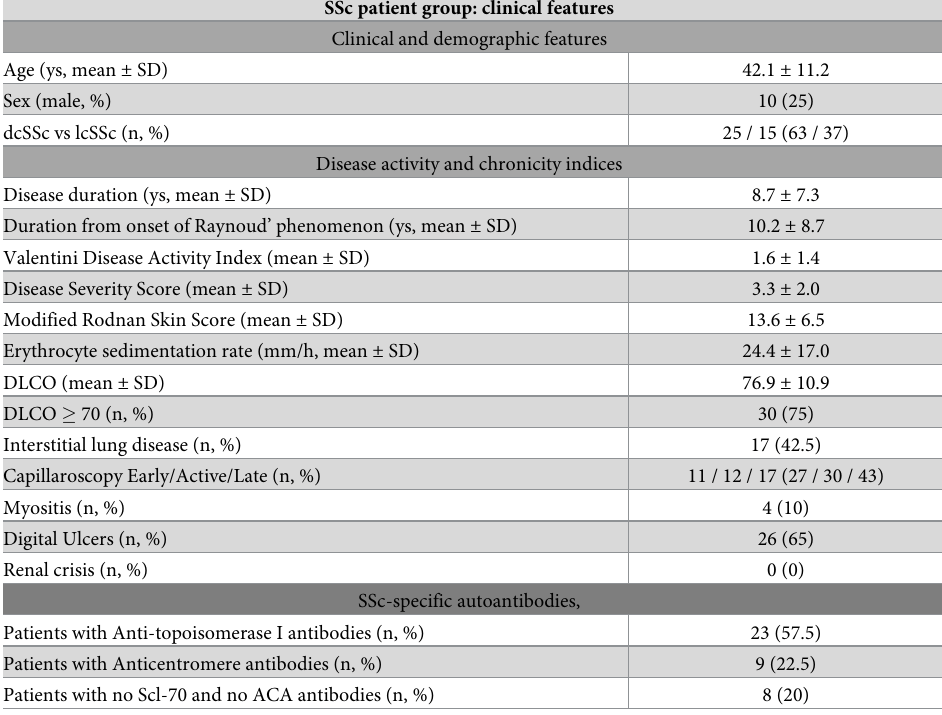
Table 1. SSc patient group: Clinical characteristics. SSc patient group: clinical